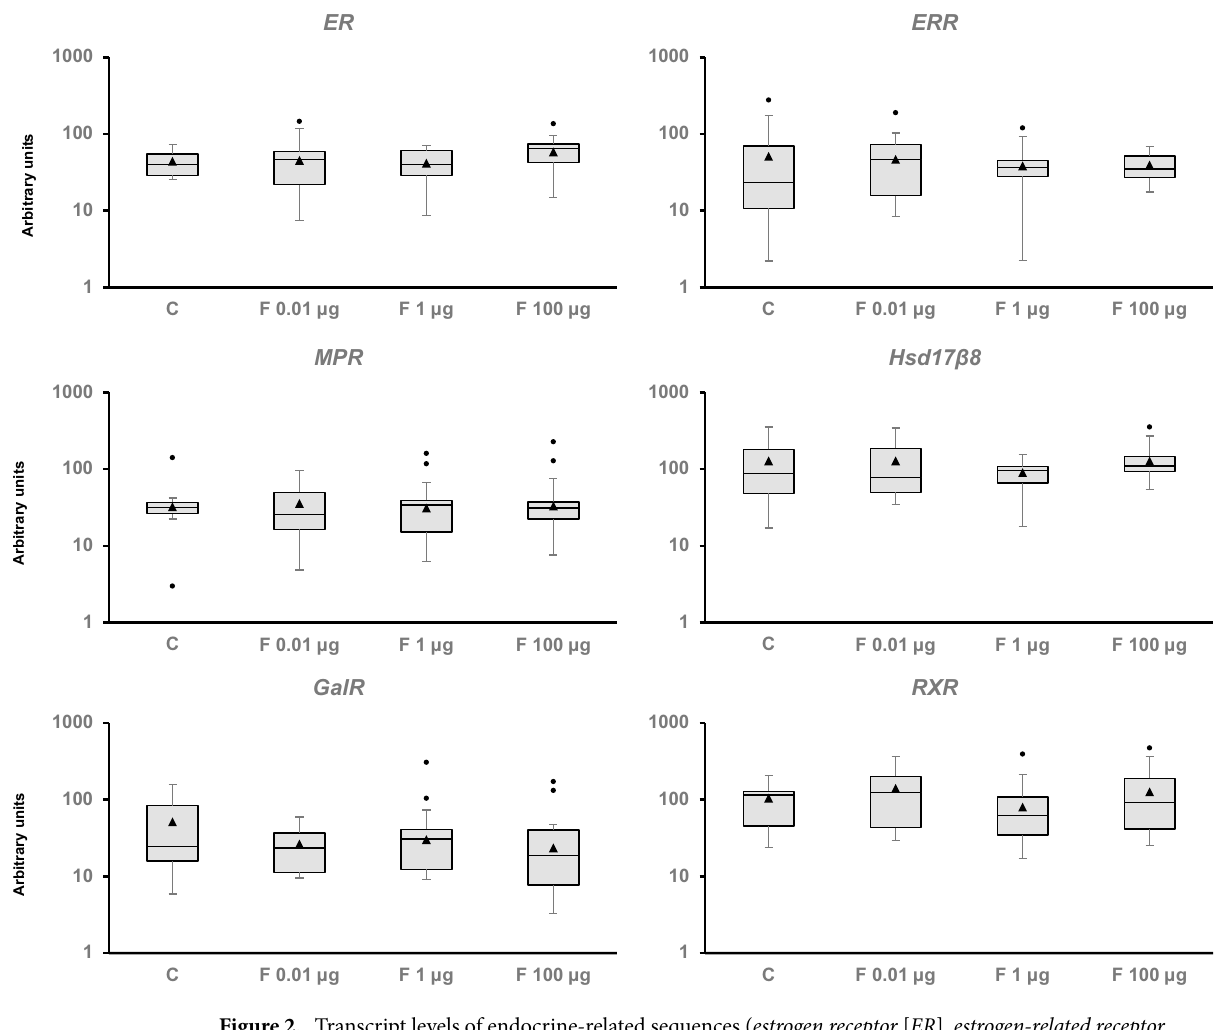
Figure 2. Transcript levels of endocrine-related sequences ( estrogen receptor [ ER ], estrogen-related receptor [ EER ], membrane progestin receptor beta [ MPR ], estradiol 17-beta-dehydrogenase 8 [ Hsd17b8 ], galanin receptor 2 [ GalR2 ], and retinoic acid receptor [ RXR ]) in Physella acuta adults after in vivo exposure to Fenoxycarb for seven days at 19 °C. Transcriptional activity was quantified by RT-PCR using ribosomal protein L10 ( rpL10 ), actin ( Act ), 6-phosphofructo-2-kinase/fructose-2,6-biphosphatase 2 ( PFKFB2 ), and glyceraldehyde-3-phosphate dehydrogenase ( GAPDH ) as reference genes. The comparison was performed with the solvent-exposed controls. Whisker boxes are shown. Each box corresponds to 12 individuals. The horizontal line within the box indicates the median, and the 25th and 75th percentiles are indicated by the boundaries of the box. The highest and lowest results are represented by the whiskers. The small triangle inside the box denotes the mean, and the outliers are shown (circles). No significant differences to control were observed in those genes (p <